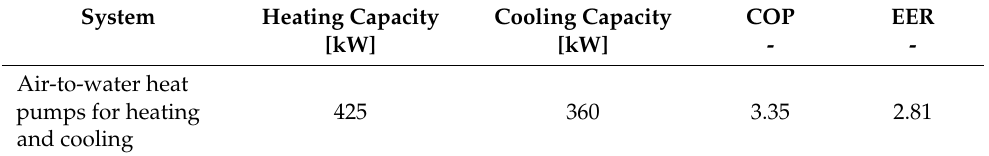
Table 3. Technical specifications of the renovated energy system.